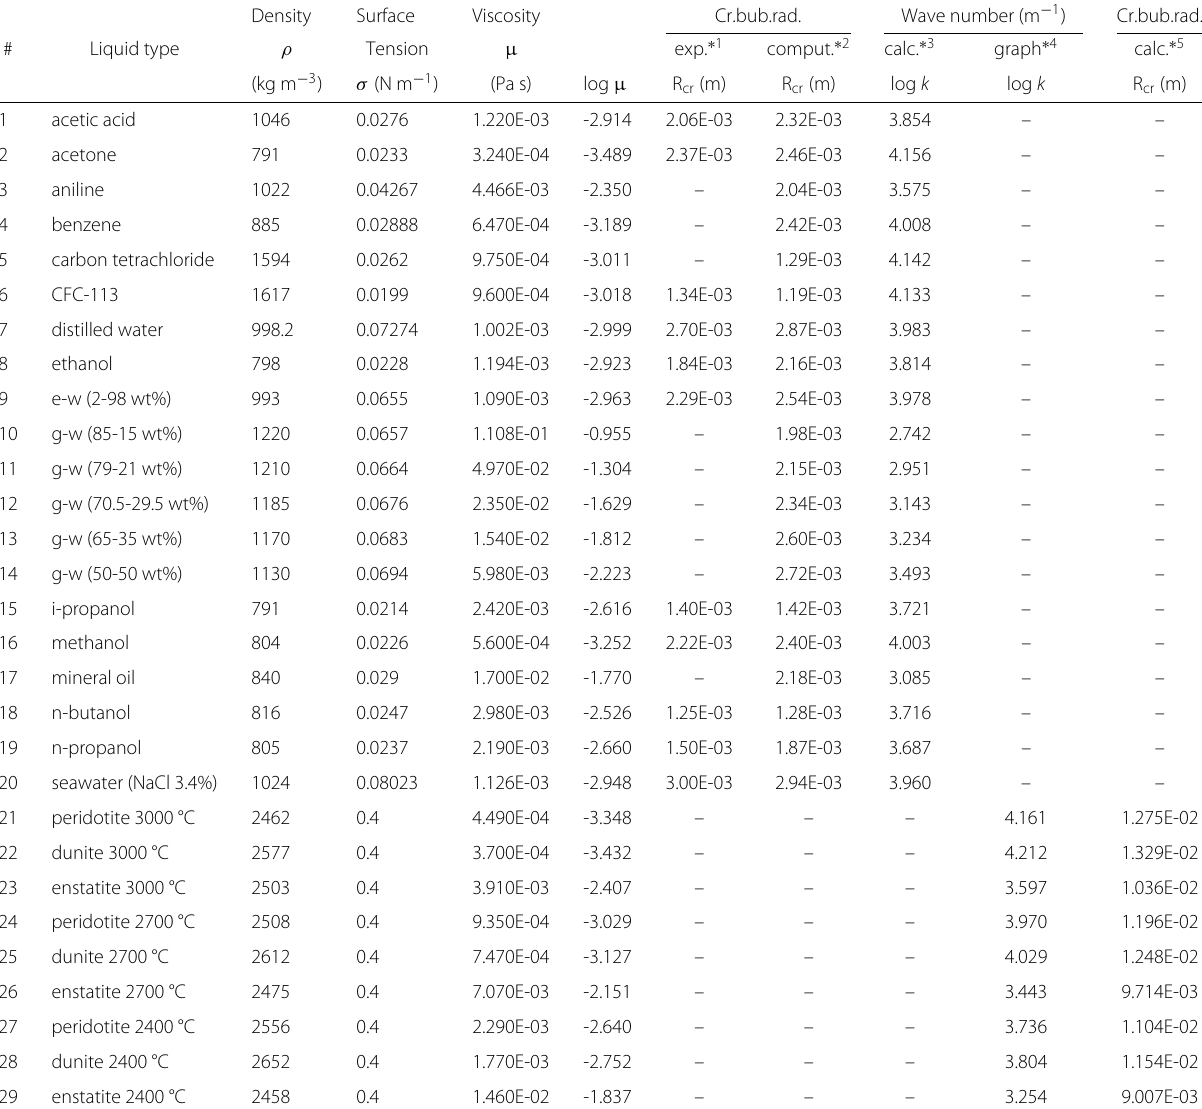
Table 7 Critical bubble radii for various liquids (modified after Georgescu et al. 2002, table 1) Density